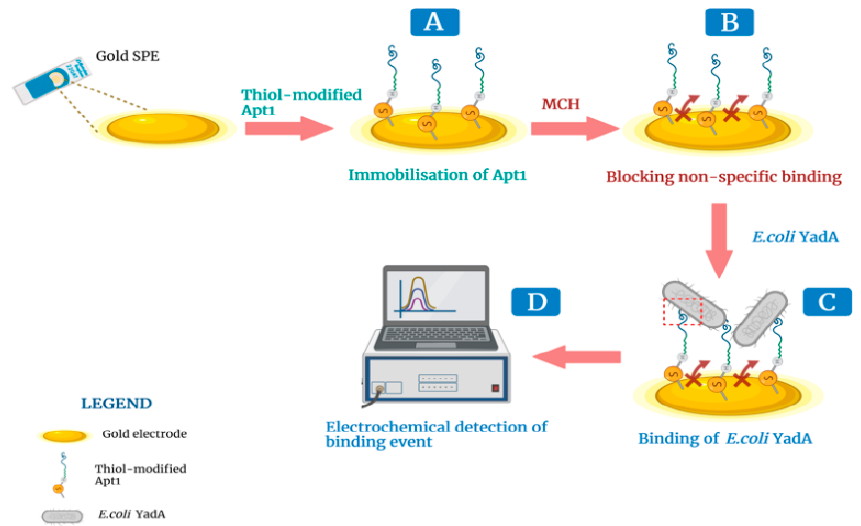
Figure 2. Schematic illustration of the sequential steps in the construction and working of an electrochemical biosensor for detection of the YadA adhesin. ( A ) Immobilization of Apt1 on the gold surface; ( B ) Blocking the inactive sites using 6-mercapto-1-hexanol (MCH) to prevent non-specific binding; ( C ) Affinity binding between Apt1 and YadA and ( D ) measurement of the electrochemical response after each step. Created with BioRender.com (accessed on 22 July 2022).